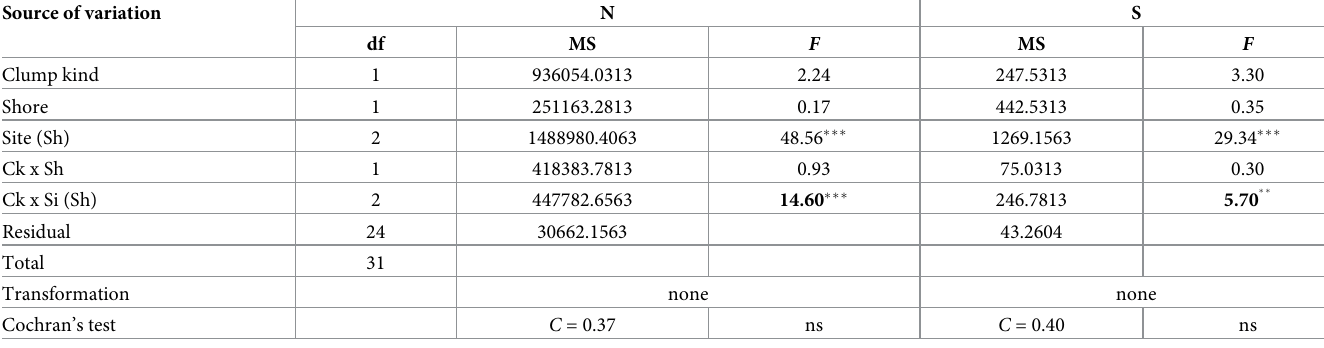
Table 2. Summary of ANOVAs evaluating the variation in the total number of individuals (N) and total number of taxa (S) between clump kinds.